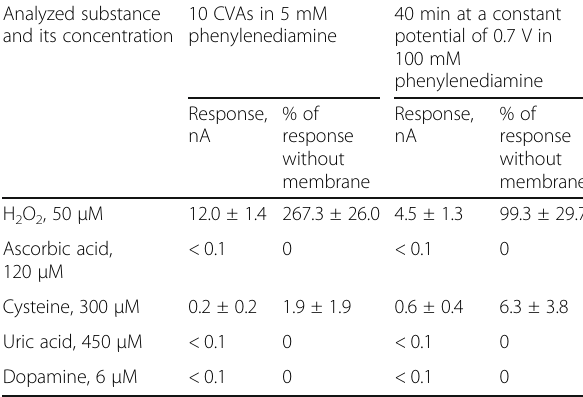
Table 3 Comparison of standard methods of deposition of PPD